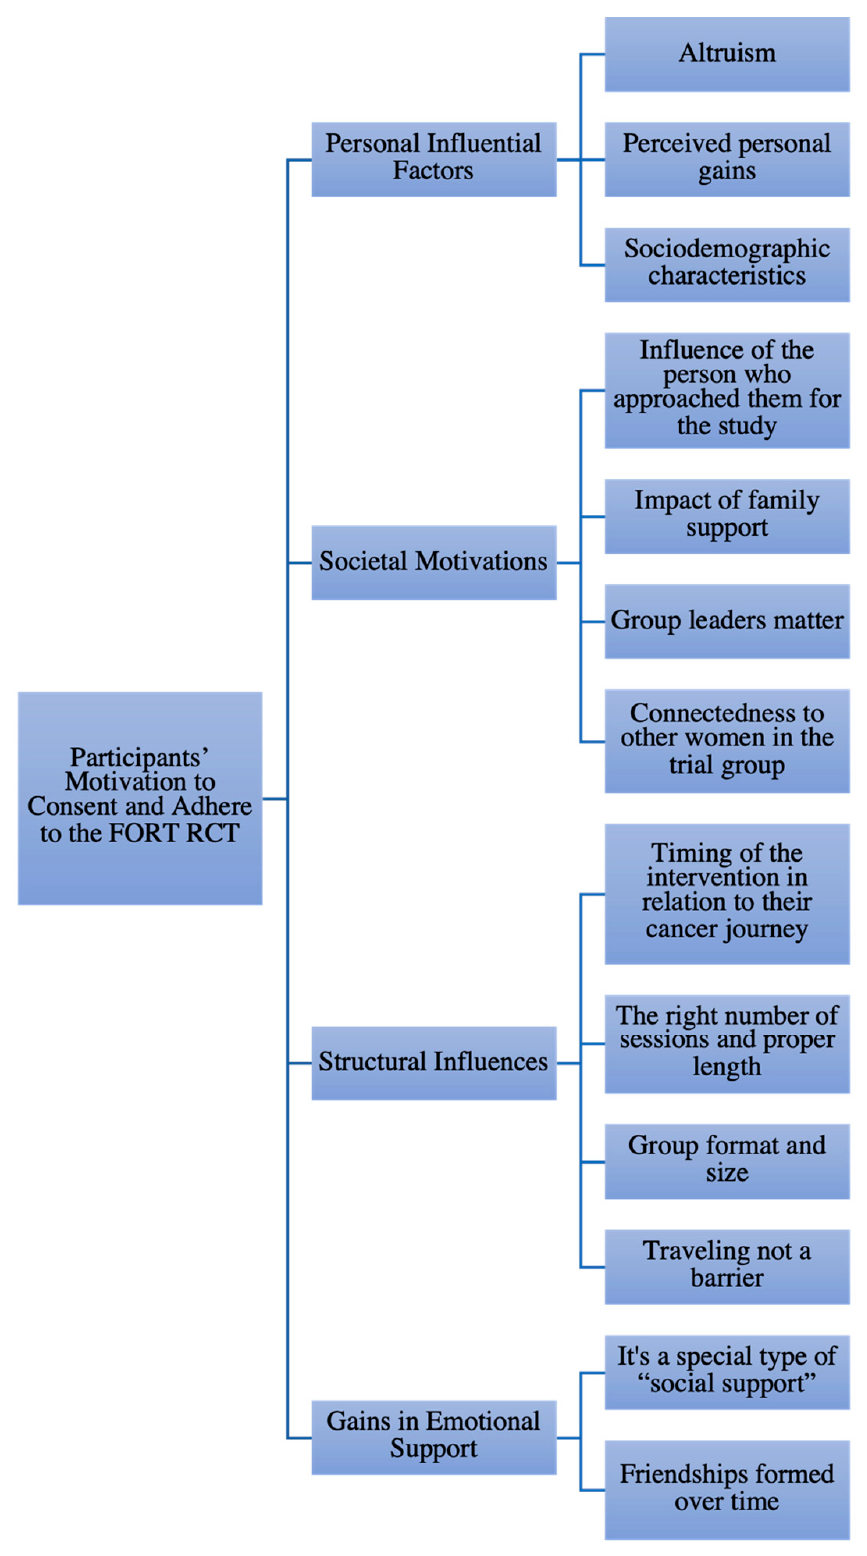
Figure 1. Motivators to consent and adhere: Emerging themes and subthemes.